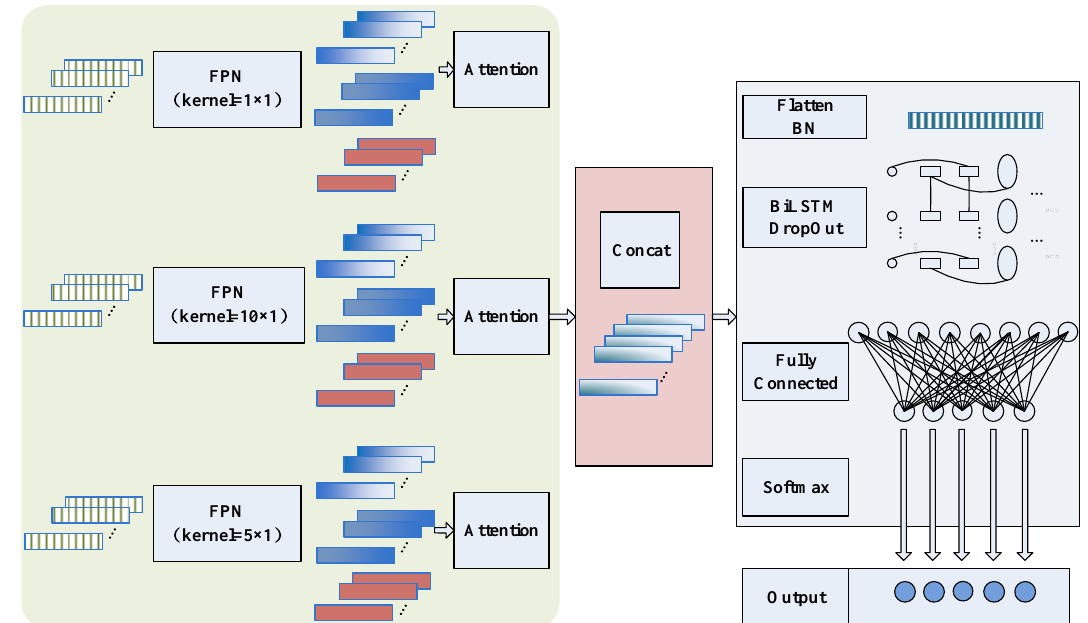
Figure 1. Structure of the proposed model.